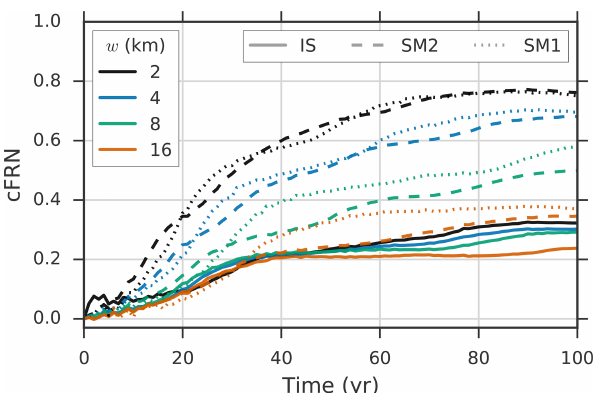
Figure 4. Time evolution of the cumulative flux response number, cFRN (Eq. 1), for the three different perturbation experiments and the four applied melt-strip widths w . Note that the total melt rate P is 2Gtyr − 1 in the IS and SM2 cases and 1Gtyr − 1 in the SM1 case for a better comparability between the SM1 and SM2